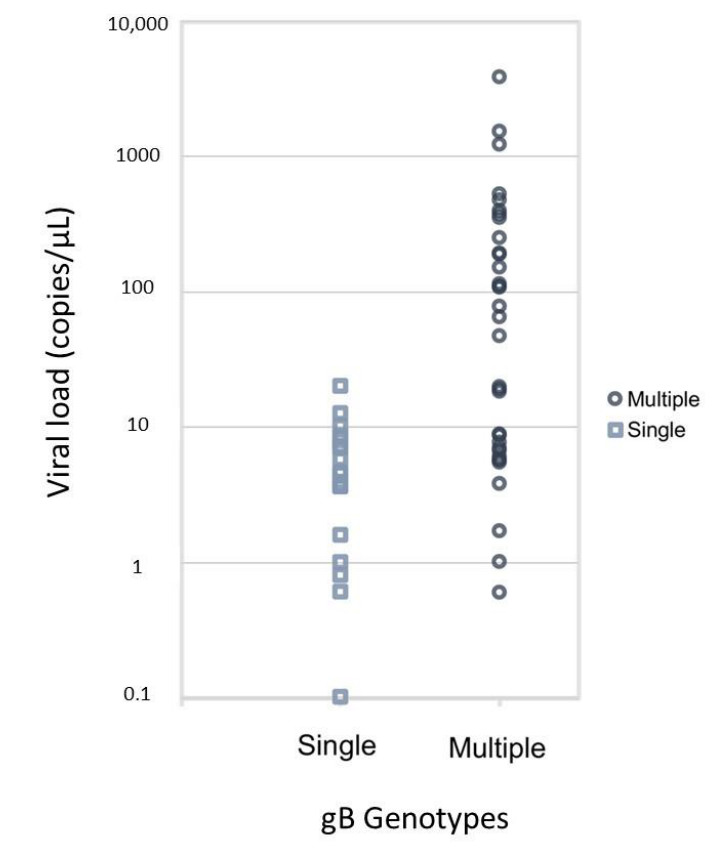
Figure 1. Single and multiple cytomegalovirus (CMV) glycoprotein (gB) genotype(s) and viral load, as measured by real-time PCR in aqueous sample from the patients with anterior segment ocular infection.